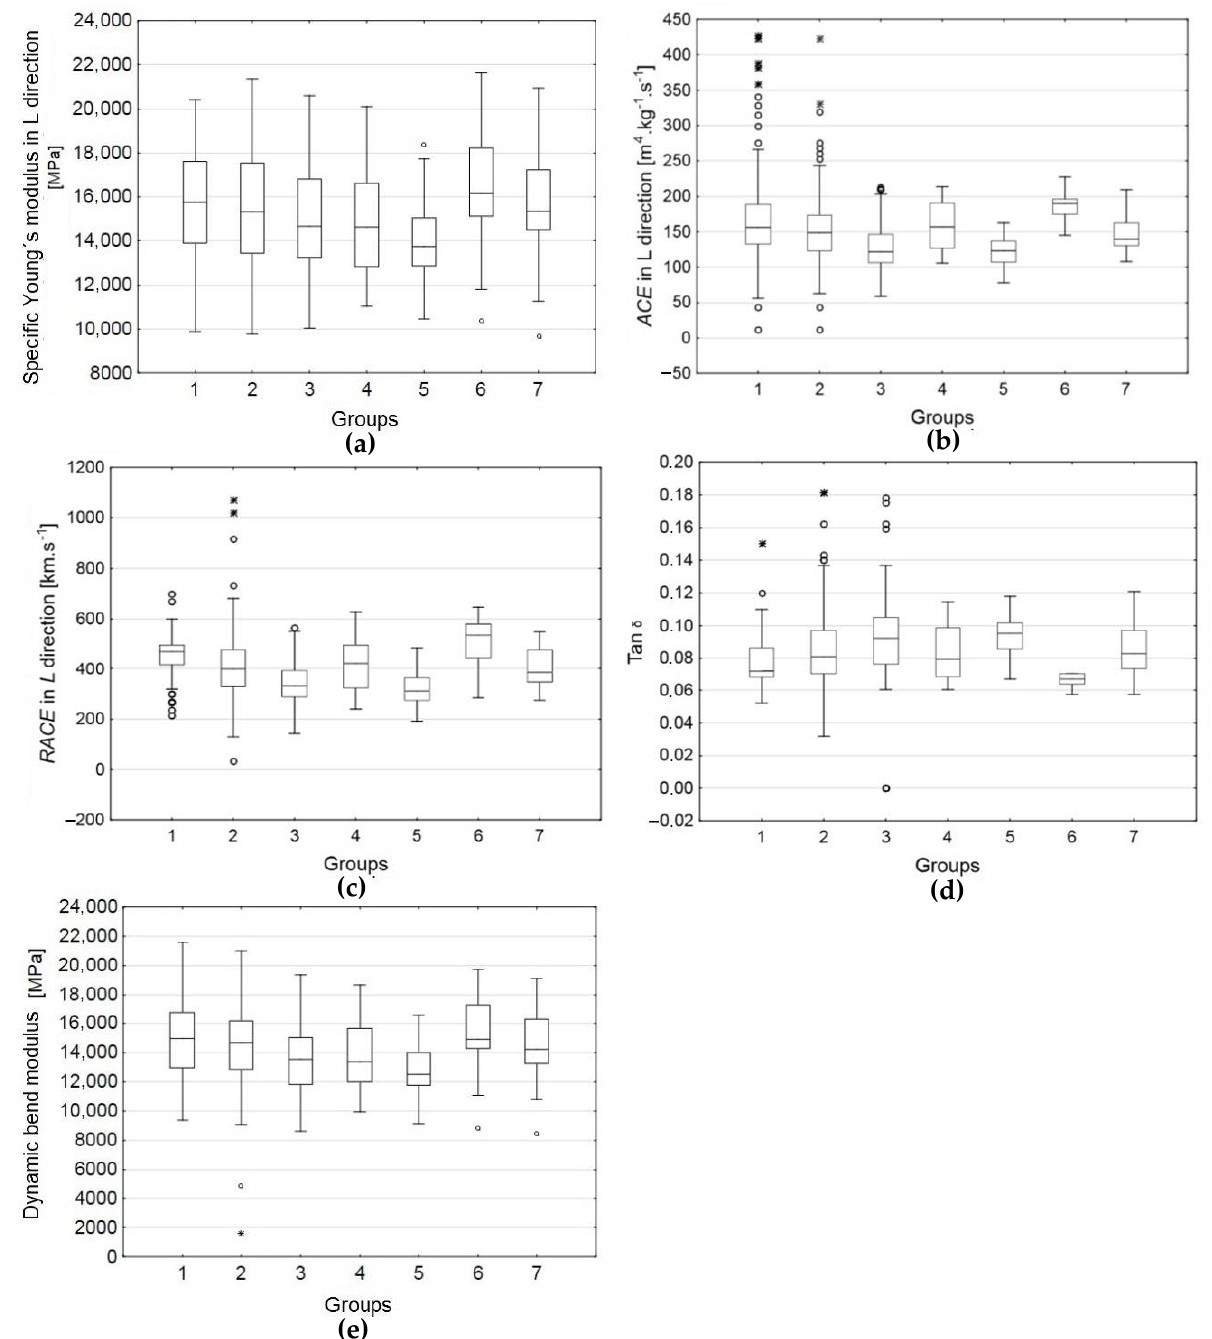
Figure 7. Distribution of acoustical properties in the specimens (group description is in Figure 7): ( a ) specific Young modulus; ( b ) acoustic conversion efficiency ( ACE L ) ; ( c ) relative acoustic conversion efficiency( RACE L ) ; ( d ) damping coefficient tan δ ; ( e ) dynamic bend modulus. ◦ —outlier values; *—extreme